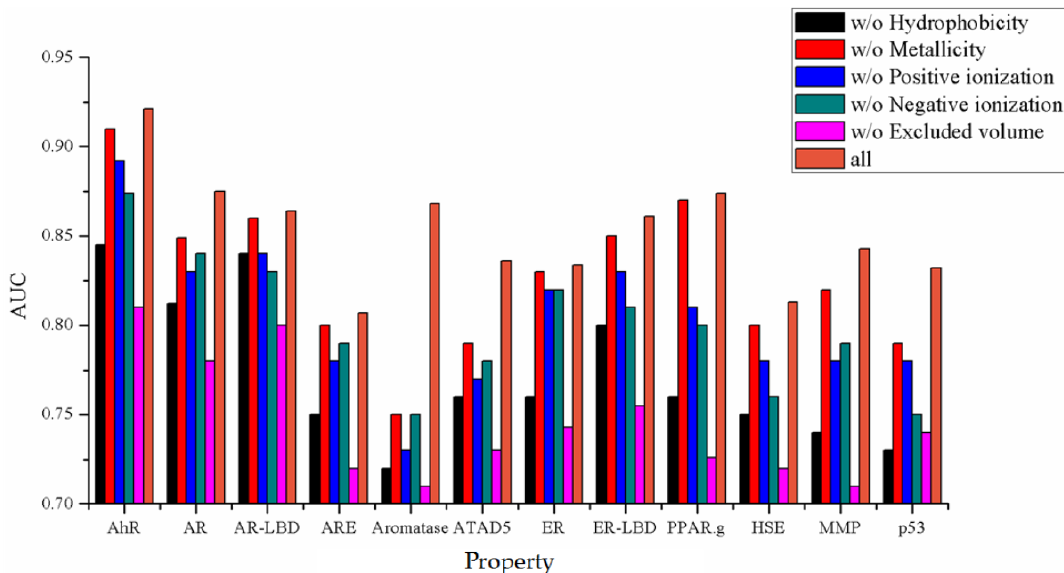
Figure 9. The results of combining all descriptors (brown) and removing one of the five descriptors.